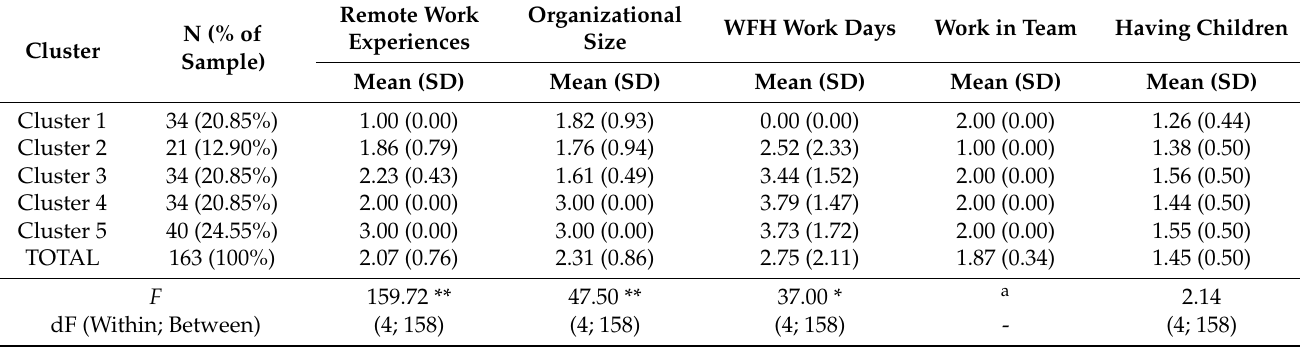
Table 4. Clusters, number of members, and grouping variable scores.